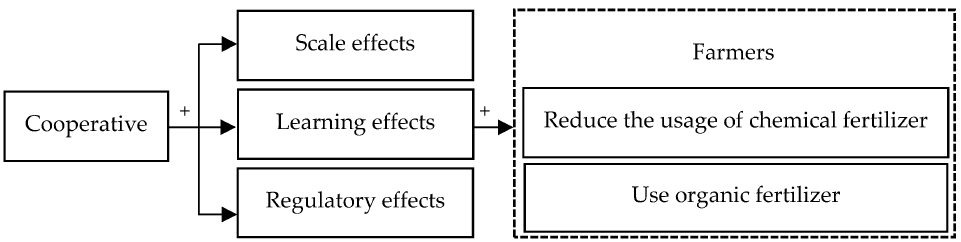
Figure 1. Theoretical framework.